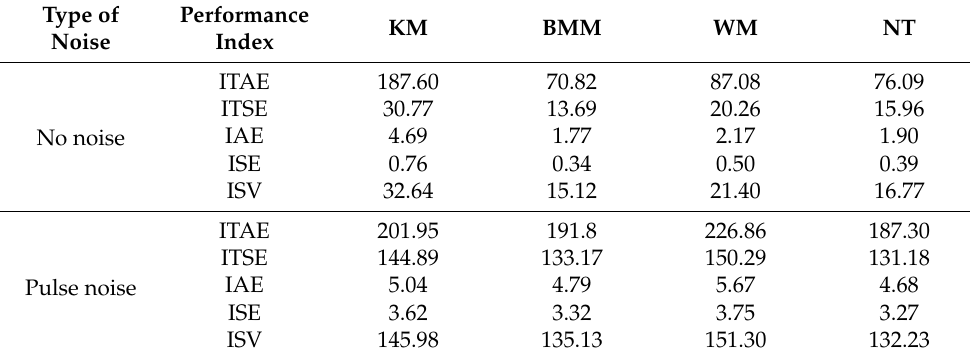
Table 4. Performance index results when inserting noise perturbations.